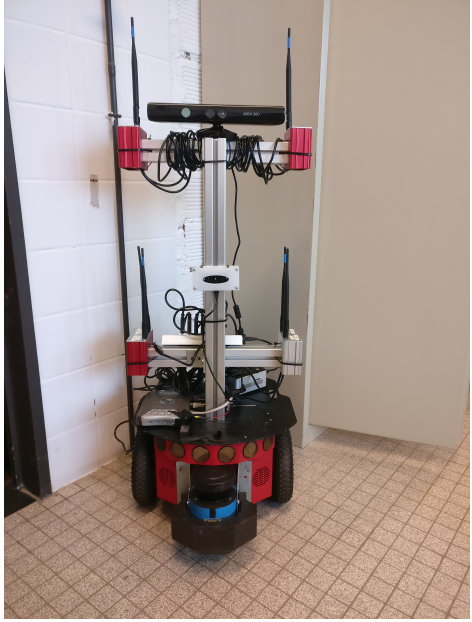
Figure 1. Picture of the Pioneer 3DX robot that was used for validating the propagation